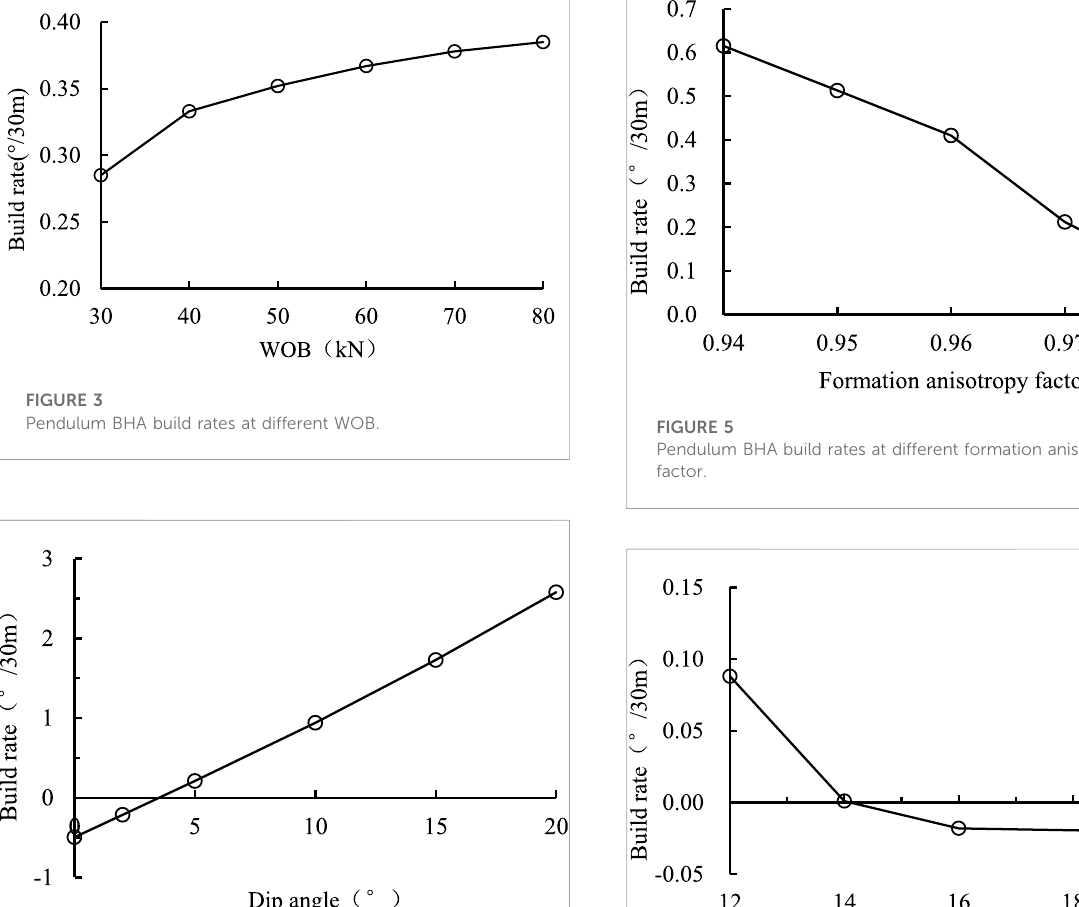
FIGURE 4 Pendulum BHA build rates at different formation dip.